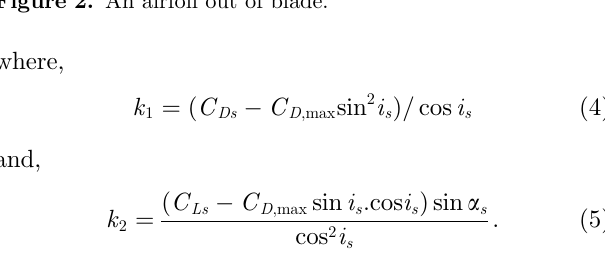
Figure 2. An airfoil out of